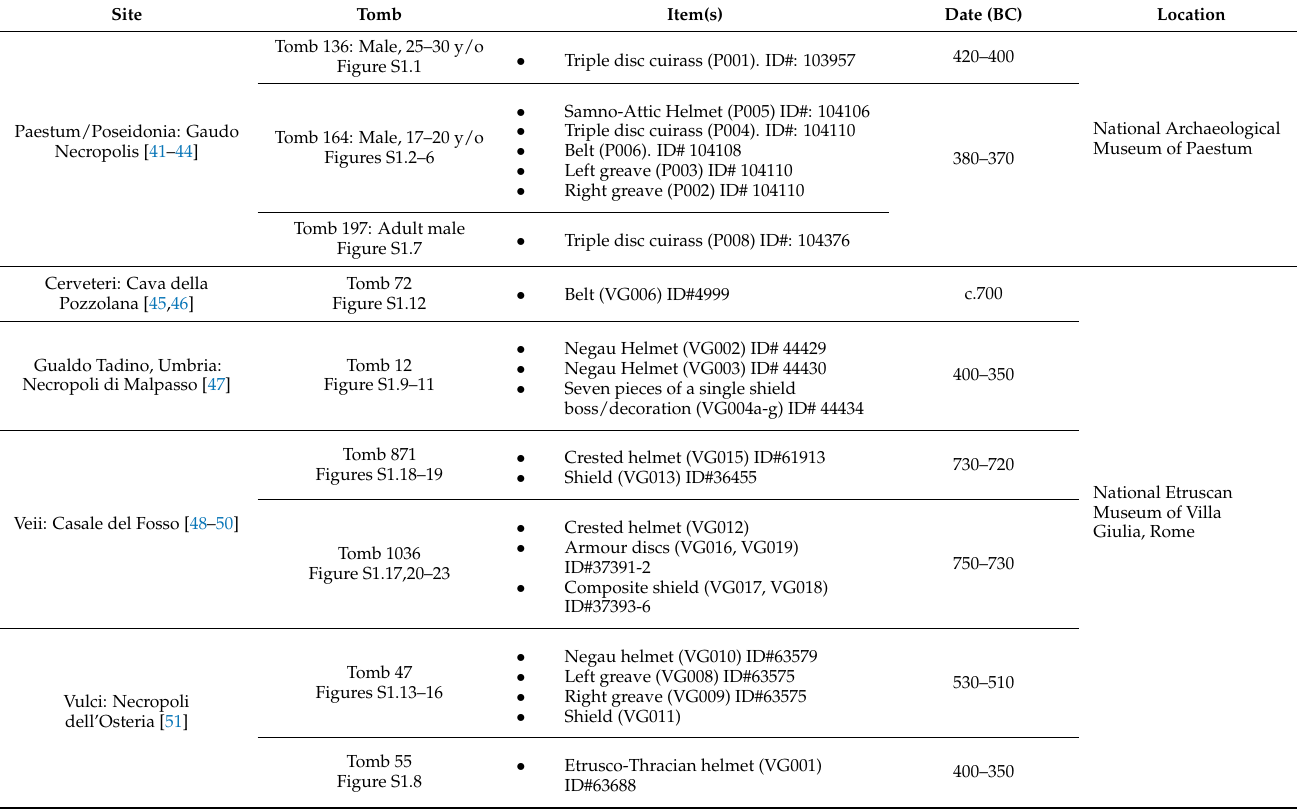
Table 1. Provenances and descriptions of the objects analysed.